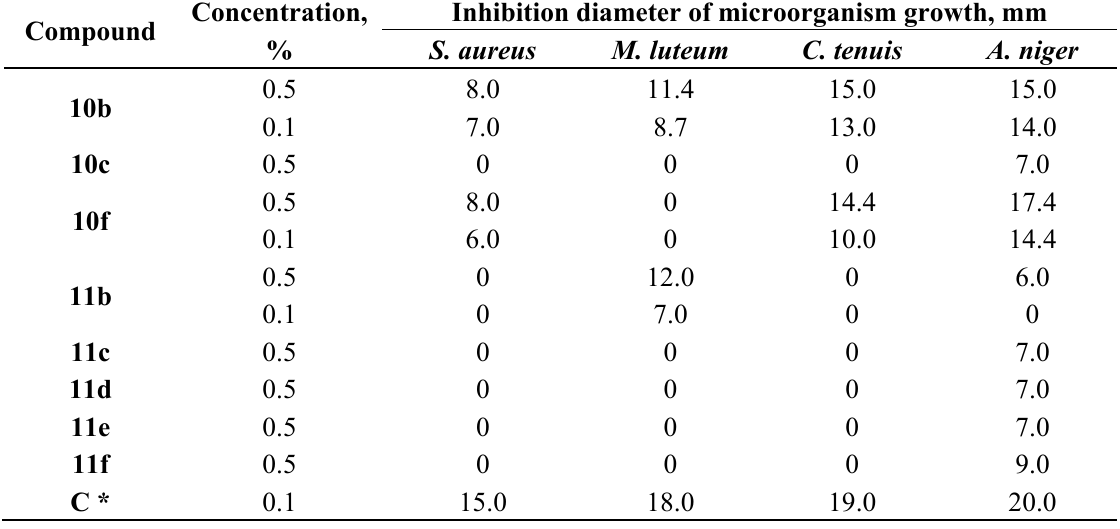
Table 1. Bactericidal and fungicidal activities of 10b – f and 11b – f determined by diffusion